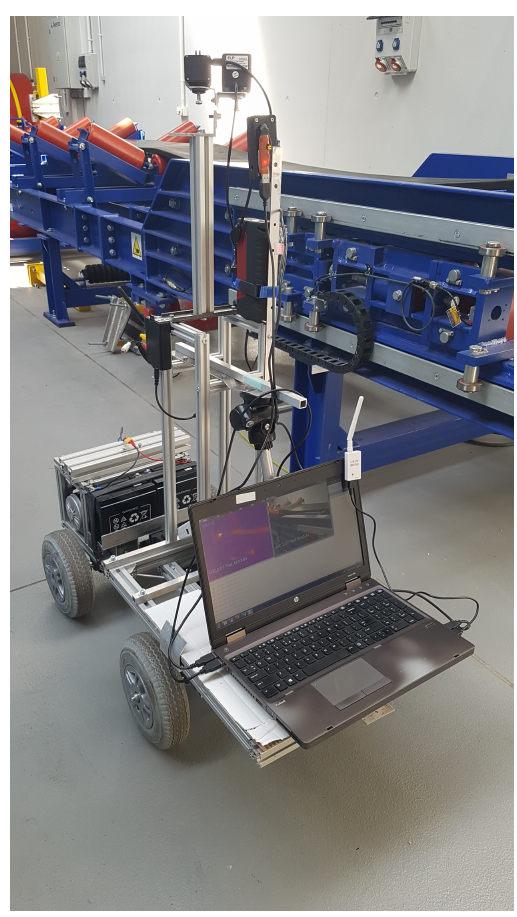
Figure 7. A robot for belt conveyor